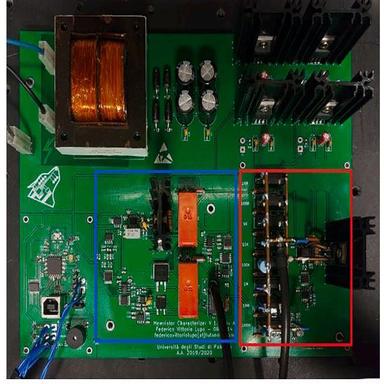
PCB picture of the assembled characterisation system. The blue square includes the circuit reported in, whilst the red region circumscribes the circuit displayed in. (For interpretation of the references to colour in this figure legend, the reader is referred to the web version of this article.)